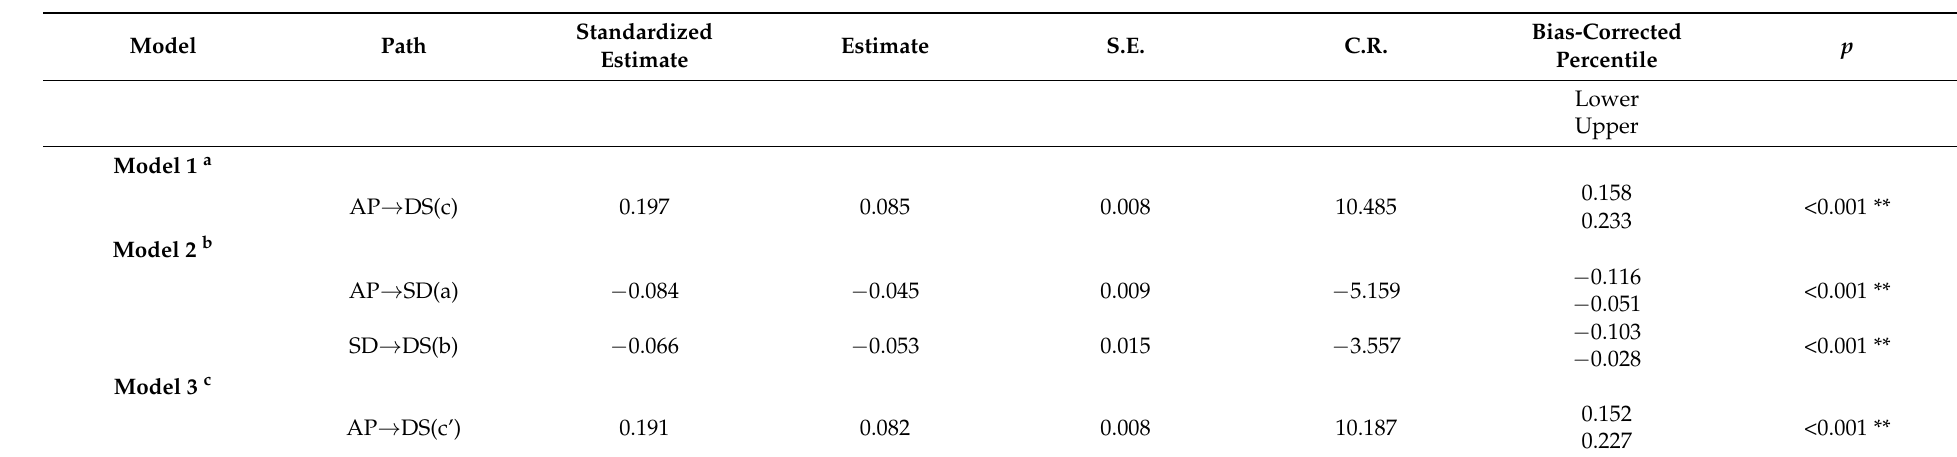
Table 5. Regression coefficients and the bootstrap test of the mediation